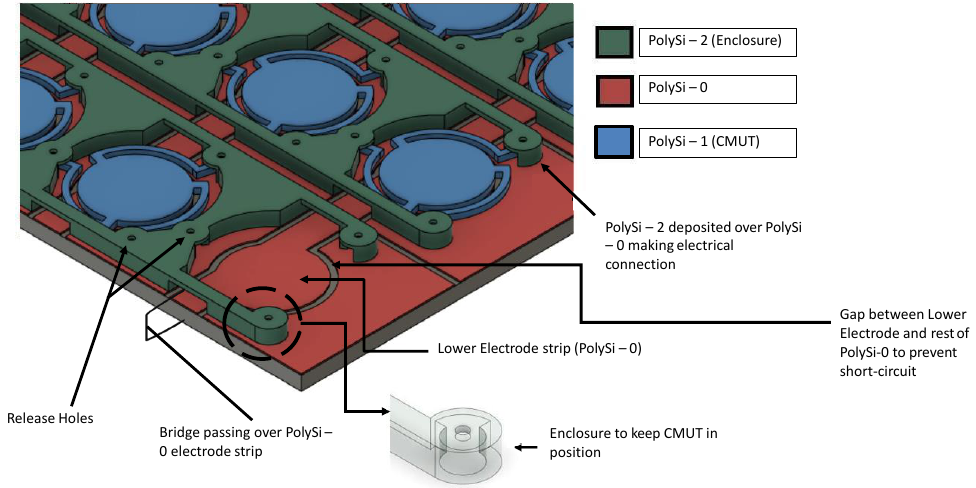
Figure 5. 3D view of the CMUT array system with PolyMUMPS layers.